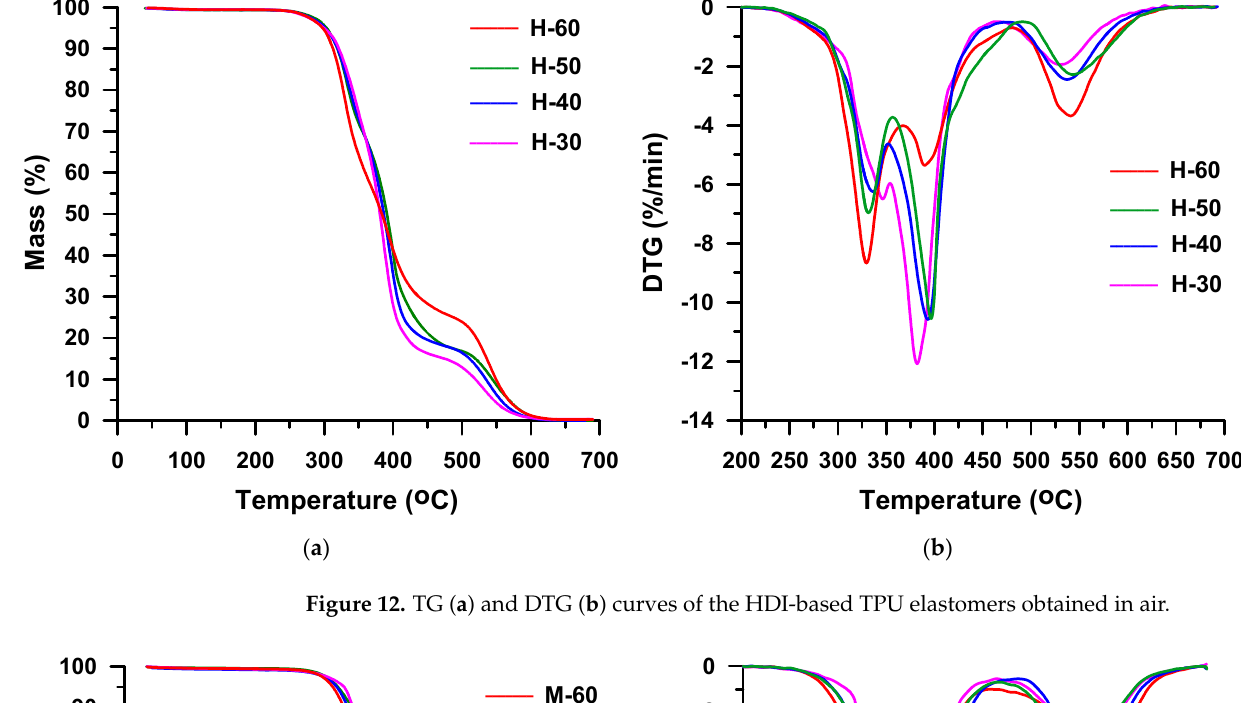
Figure 12. TG ( a ) and DTG ( b ) curves of the HDI-based TPU elastomers obtained in air.